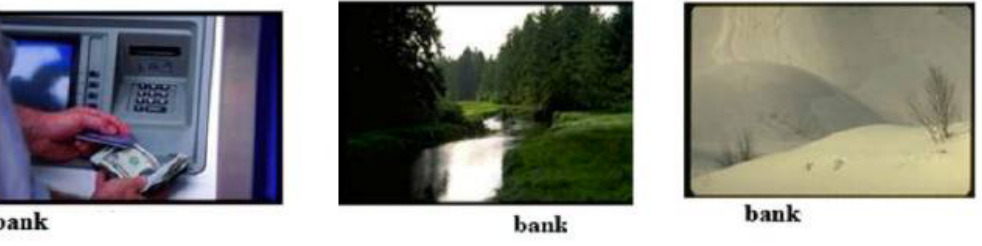
Figure 4. The common assumption is that words disambiguate pictures, but the reverse can also be as true